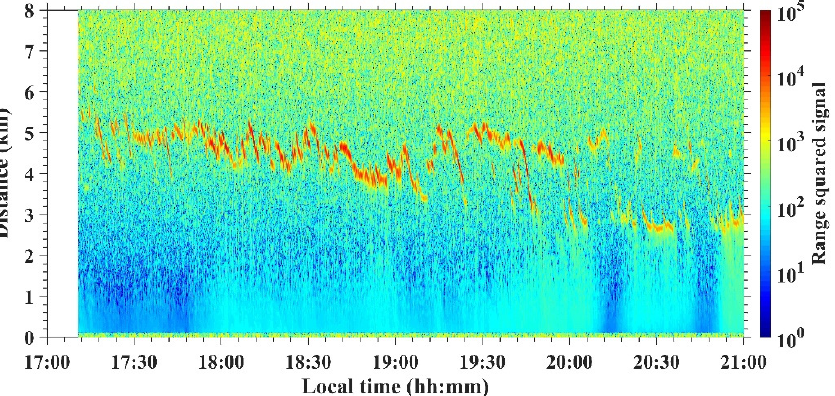
Figure 9. Temporal and spatial evolution of the range squared signal from 25–26 December 2021 with a temporal resolution of 1 min and a spatial resolution of 9.8 m.